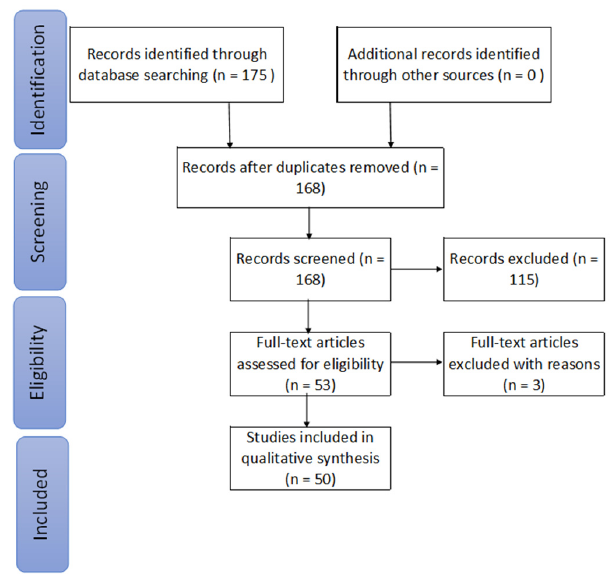
Figure 1. Chart of the selection strategy following PRISMA guidelines [13].